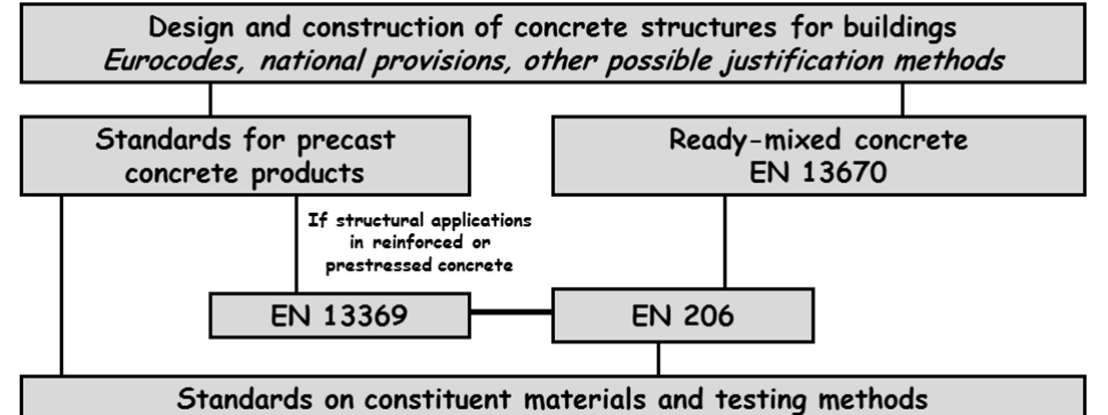
Figure 1 . European standardisation context for concrete